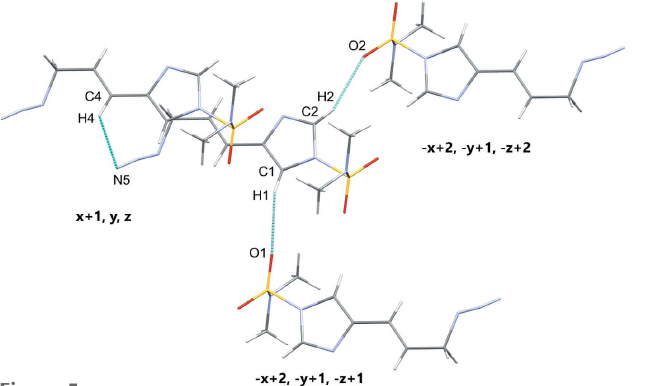
Figure 5 Close contacts for compound 1 .